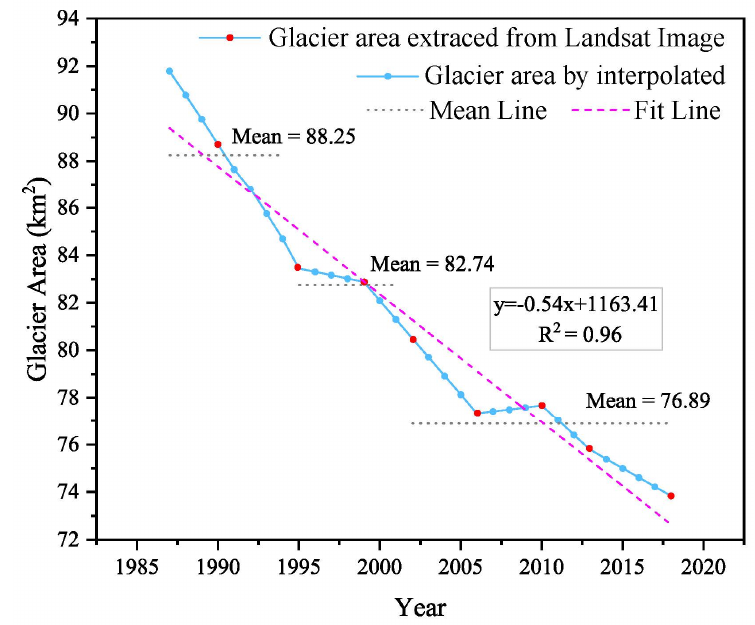
Figure 6. The area of glaciers in the Hala Lake Basin from 1997 to 2018.